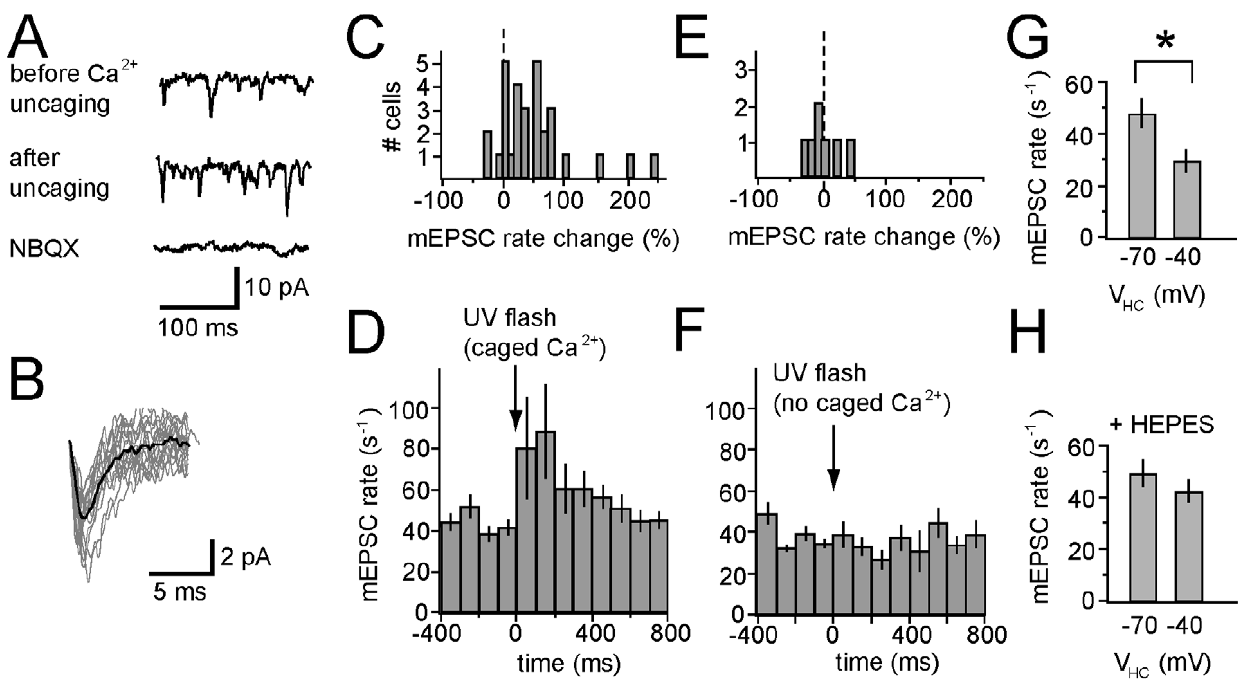
Figure 7. Uncaging Ca 2 + in HCs increases glutamate release from photoreceptors. (A) Spontaneous inward currents recorded from an HC before (top trace) and after (middle trace) UV flash photolysis of caged Ca 2 + (DM-nitrophen). Uncaging Ca 2 + appeared to increase the frequency of mEPSCs. Spontaneous inward currents were eliminated after blocking AMPA receptors with 10 m M NBQX (bottom trace), identifying them as glutamatergic mEPSCs. (B) Average mEPSC waveform used for template matching (dark trace) and 10 individual events that were classified as mEPSCs. (C) Histogram showing distribution of HCs exhibiting increases or decreases in peak mEPSC rate after Ca 2 + uncaging. (D) Time course of the change in mEPSC rate after Ca 2 + uncaging. The time course reflects the average mEPSC rate from 31 HCs. (E) Histogram showing distribution of HCs exhibiting increases or decreases in peak mEPSC rate after UV flash when DM-nitrophen was absent from the pipette solution. (F) Time course mEPSC rate after UV flash, in the absence of DM-nitrophen. The time course reflects the average mEPSC rate from seven HCs. (G) Depolarization of HCs from 2 70 mV to 2 40 mV results in a statistically significant ( p , 0.05) decrease in average mEPSC rate ( n =4). (H) Depolarization of HCs from 2 70 mV to 2 40 mV fails to cause a significant increase in mEPSC rate after addition of HEPES (10 mM) to the bathing medium ( n